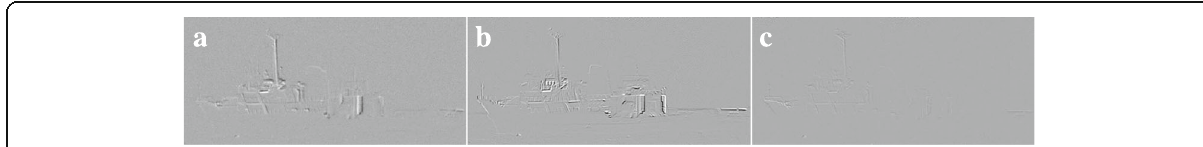
Fig. 9 Stabilization results for the ship in Fig. 3. Frame-to-frame differences are shown between the raw frames ( a ), the processing results with a global motion model estimated in the center of the ship ( b ), and for the proposed dynamic turbulence mitigation with Lucas-Kanade optical flow ( c